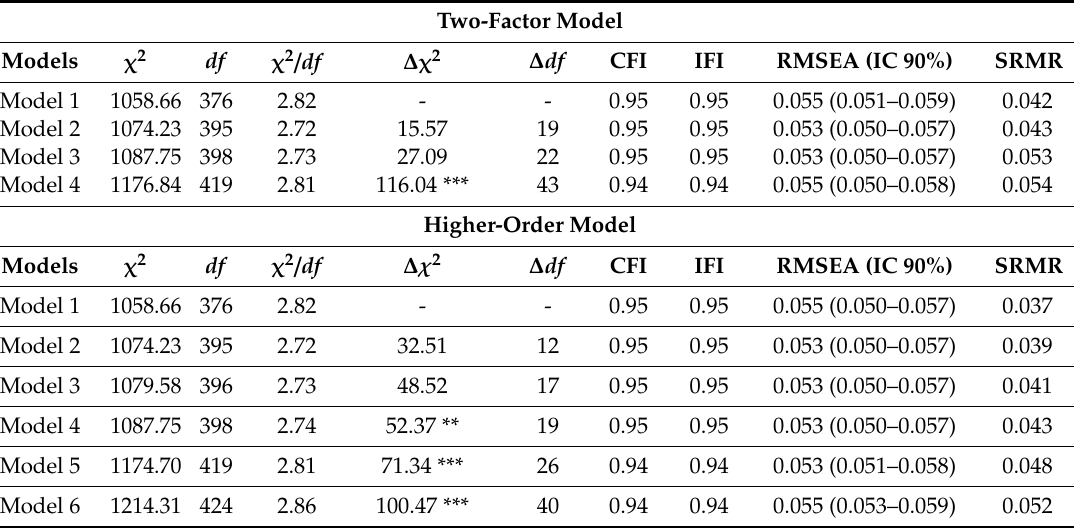
Table 3. Gender invariance analysis. Two-Factor Model